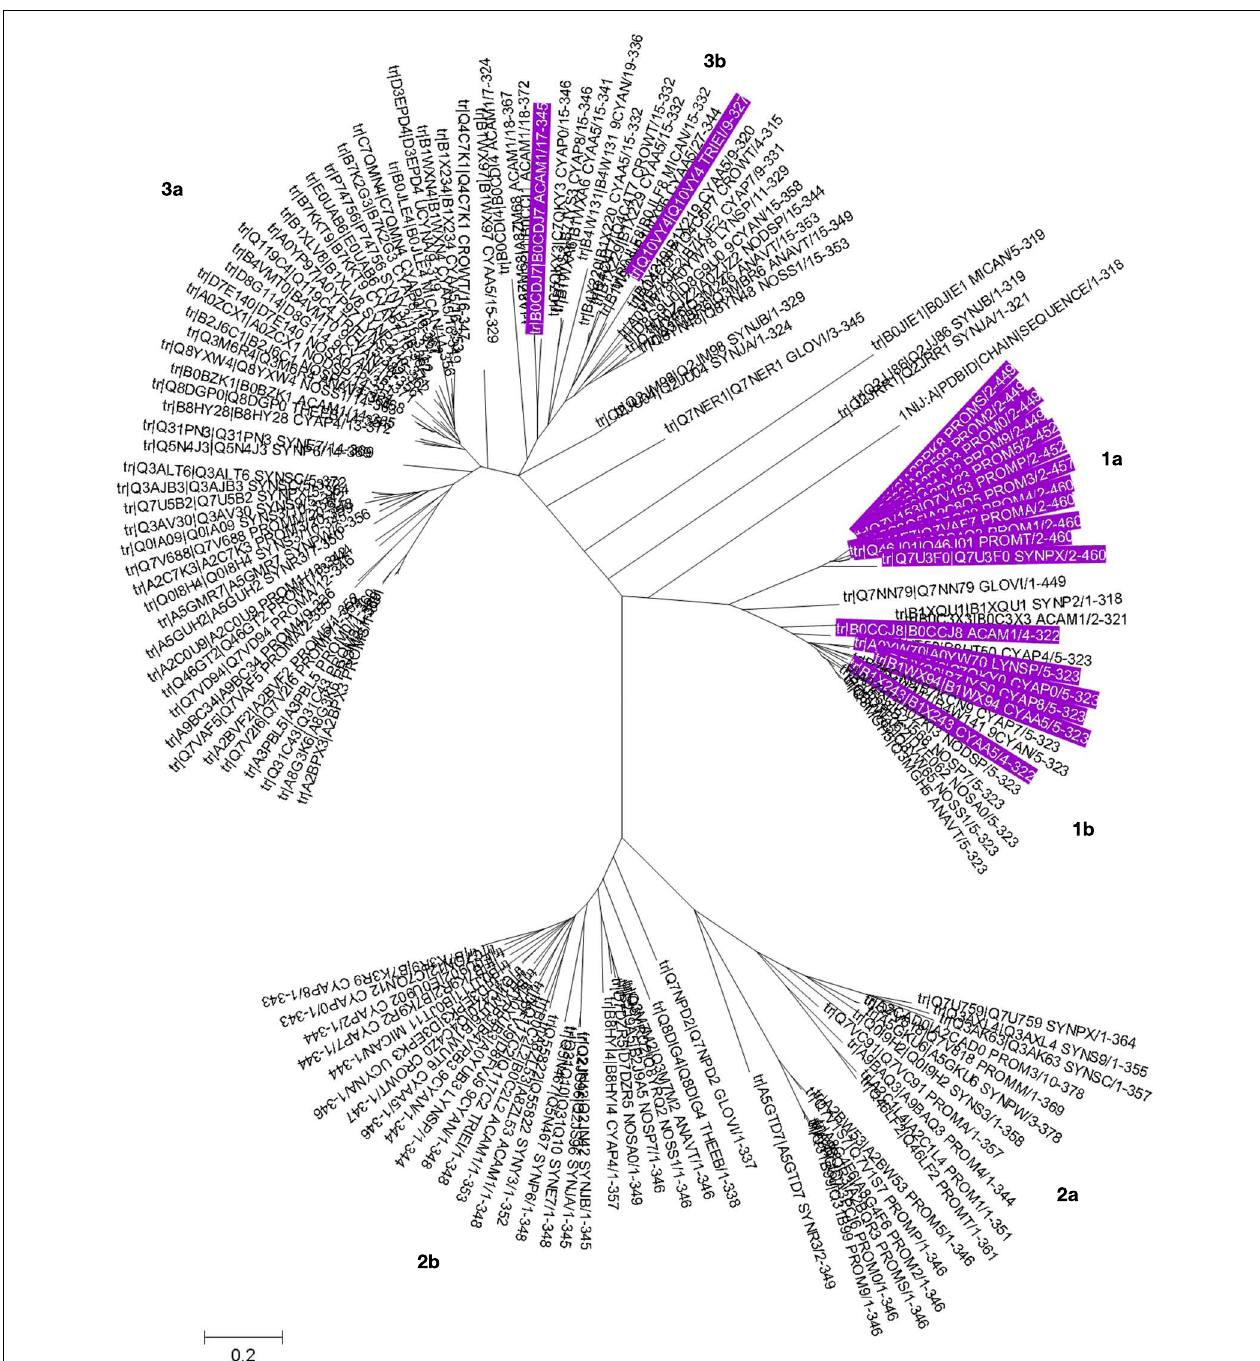
rectangular tree including bootstrap statistics can be found Figure S4 in Supplementary Material.The sequence of E. coli YjiA, the only COG0523 member for which an experimentally determined structure is available, was also included in the tree. Entries with a genomic context linked to zinc homeostasis are highlighted in purple (also see Table 1 ). Sub-branches are labeled and discussed in the main